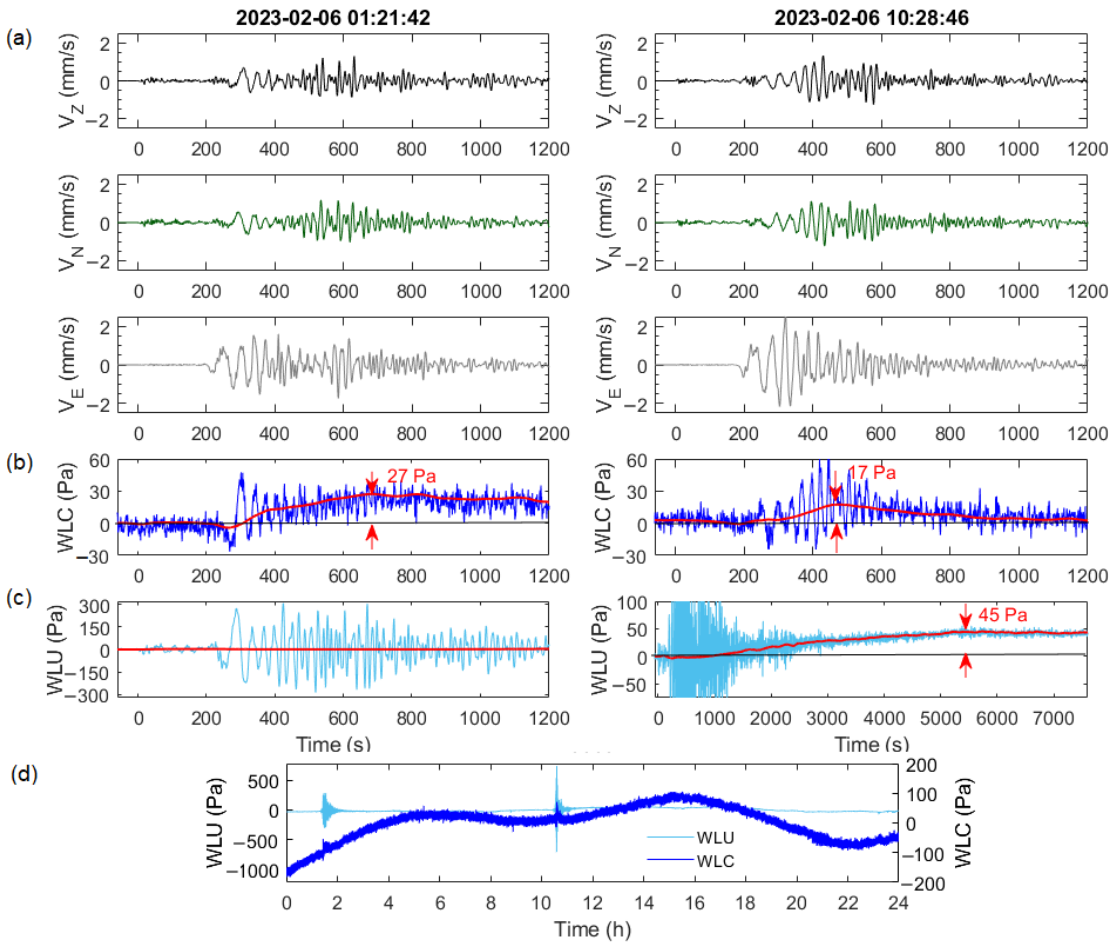
Figure 8. Diagrams of ground velocity (Z, N, E components, three top panels) ( a ), WLC ( b ) and WLU ( c ) aquifers during the passage of seismic waves from earthquakes in Turkey on 6 February 2023 M 7.8 01:21: 42 (left) and on 6 February 2023 M 7.7 10:28:46 (right), one-day data series of WLC and WLU without influence of atmospheric pressure ( d ). Red line—smooth curve, which shows postseismic effect.